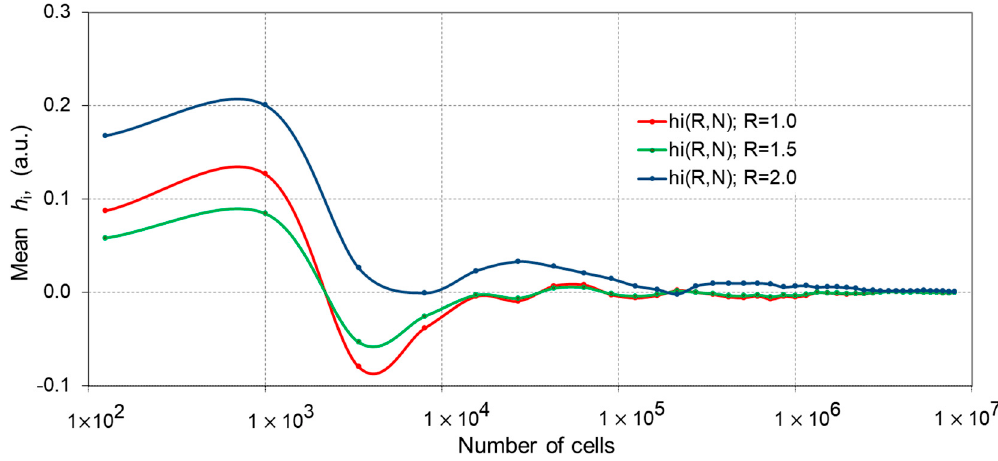
Figure 1. Mean estimator of pseudo-random sets of h i fields against the number of spins N.